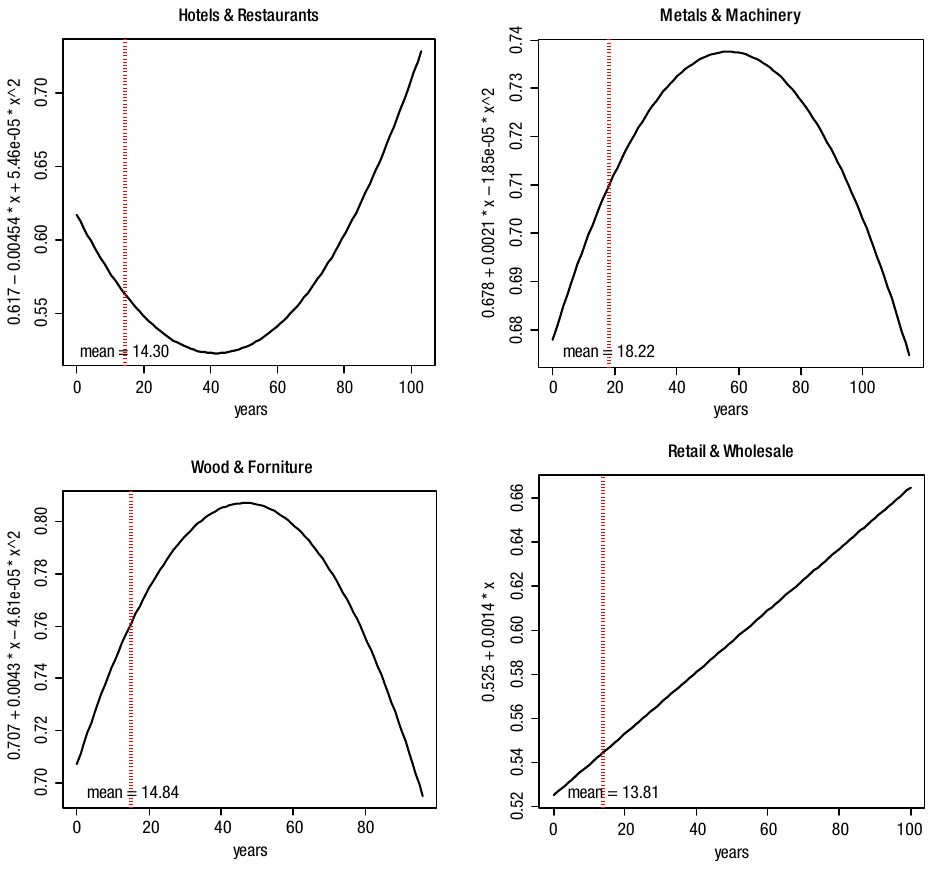
Fig. 4. Different patterns of the relationship between age and corrected